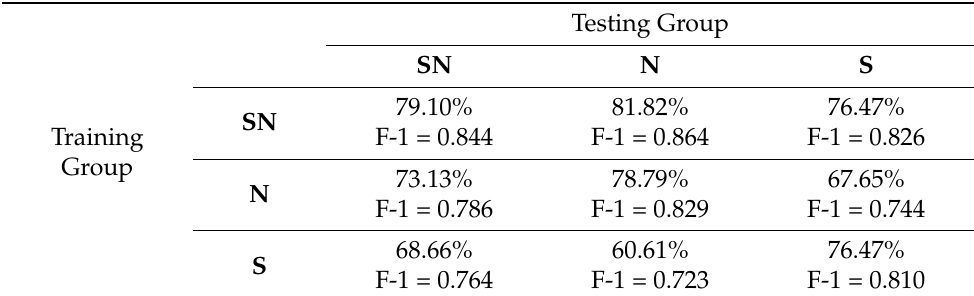
Table 4. Accuracy and F-1 scores of the Random Forest algorithm (when using best 2% of the features) after training it on one group and testing on